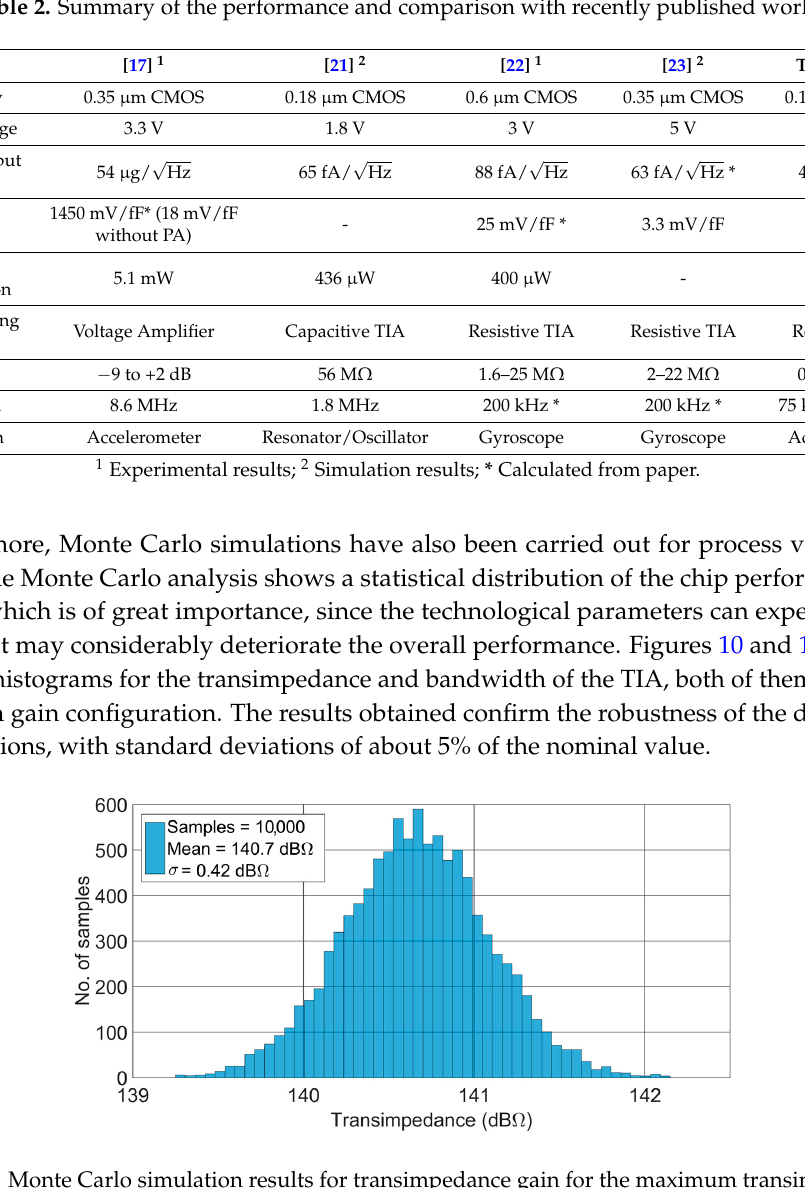
Table 2. Summary of the performance and comparison with recently published works.